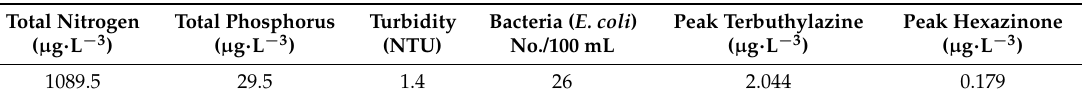
Table 7. Comparison of modeled peak terbuthylazine and hexazinone concentrations at the Rangitaiki flow gauge with other water quality parameters